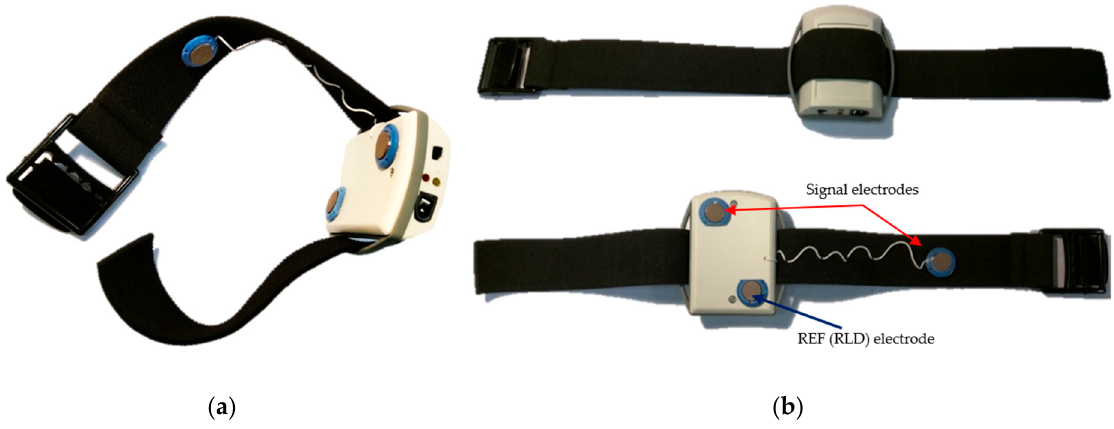
Figure 7. Arm-ECG sensor system WAMECG1: ( a ) prototype assembly; ( b ) top and bottom views of the system.